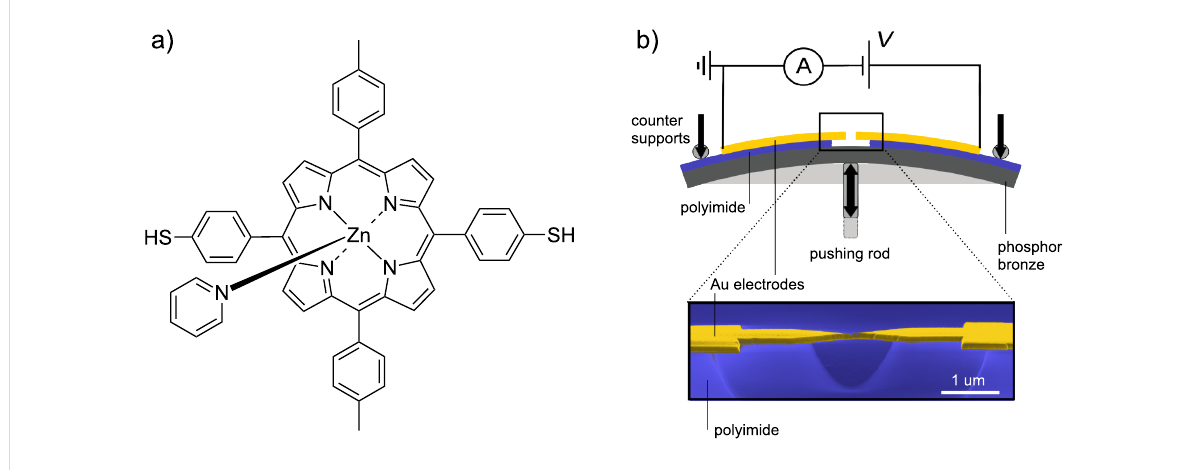
Figure 1: Structural formula of ZnTPPdT–Pyr (b) Top: Setup of the mechanically controllable break-junction (MCBJ). Bottom: Scanning electron micrograph of a MCBJ device (colorized for clarity). The scale bar shows that the suspended bridge is about 1 µm in